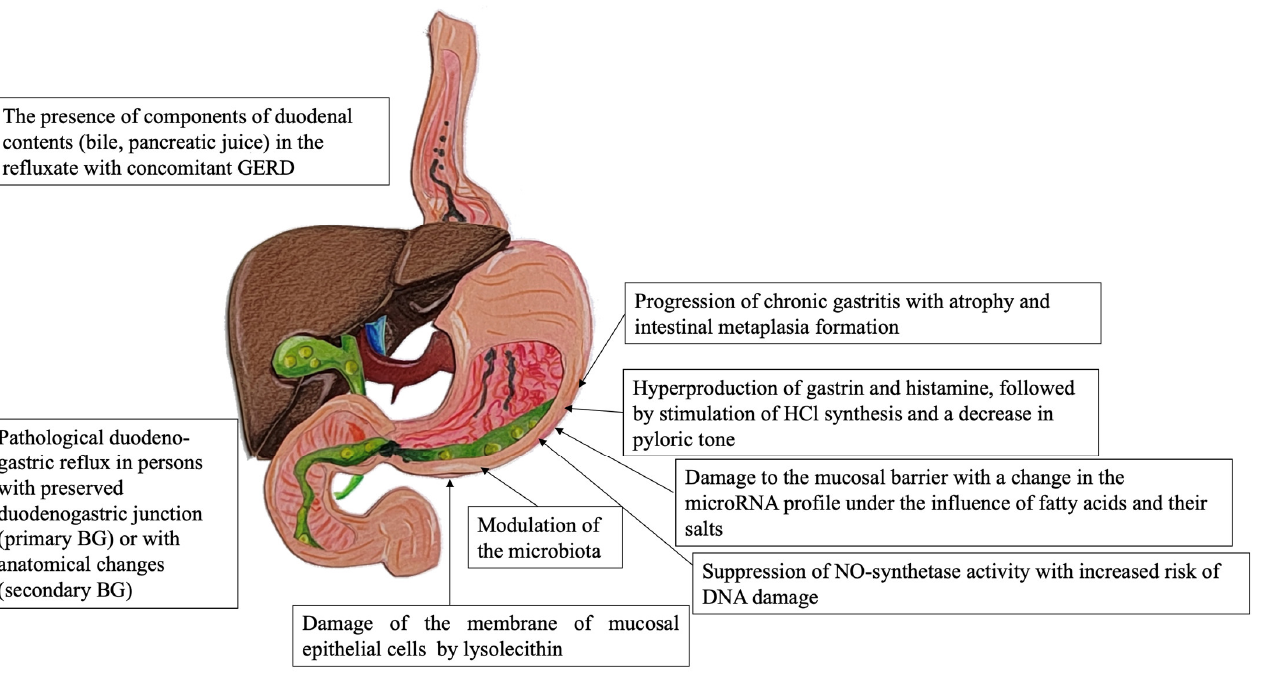
Figure 1. The main correlations in the pathogenesis of BG. BG—biliary gastritis, GERD—gas- troesophageal reflux disease, BA—bile acids, GM—gastric mucosa. esophageal reflux disease, BA—bile acids, GM—gastric